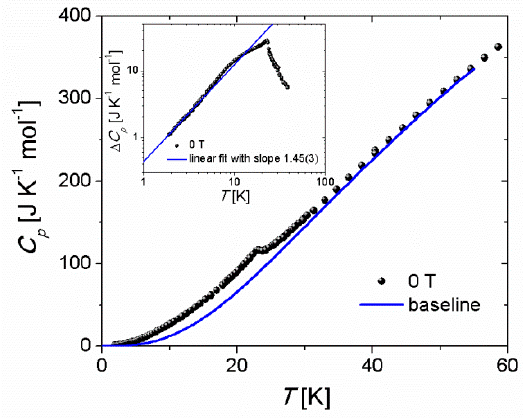
Figure 9. Zero-field total heat capacity of 2 (symbols) with the baseline (solid line). Inset: Zero-field magnetic excess heat capacity in the log-log plot (symbols) with the linear fit in the low temperature regime (solid line).